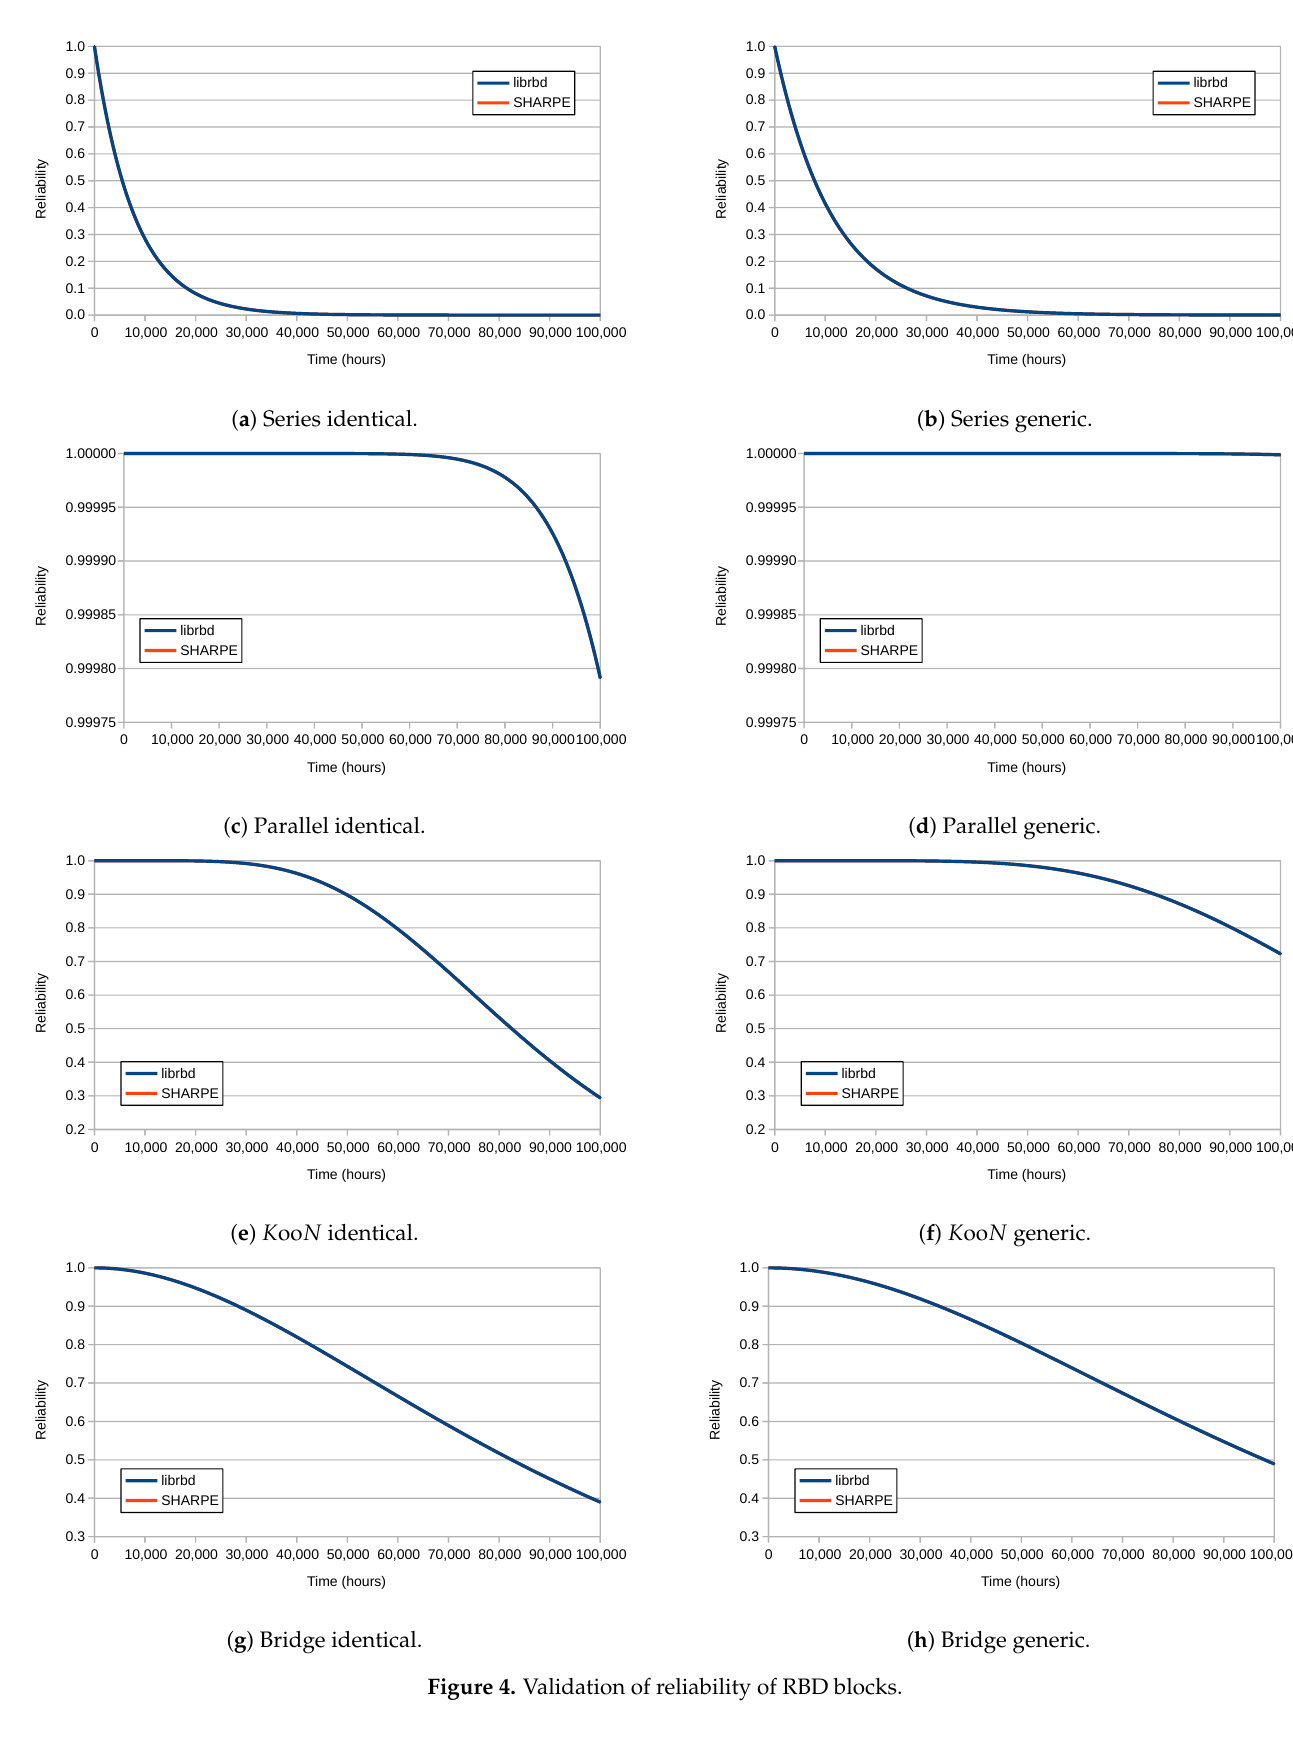
Figure 4. Validation of reliability of RBD